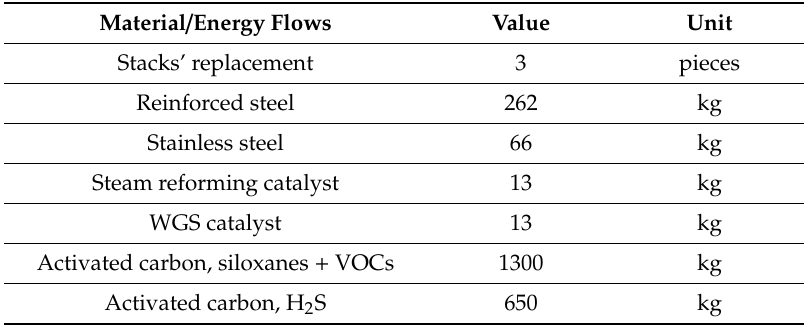
Table 6. Maintenance of the SOFC based CHP system. Reference flow: maintenance interventions in one